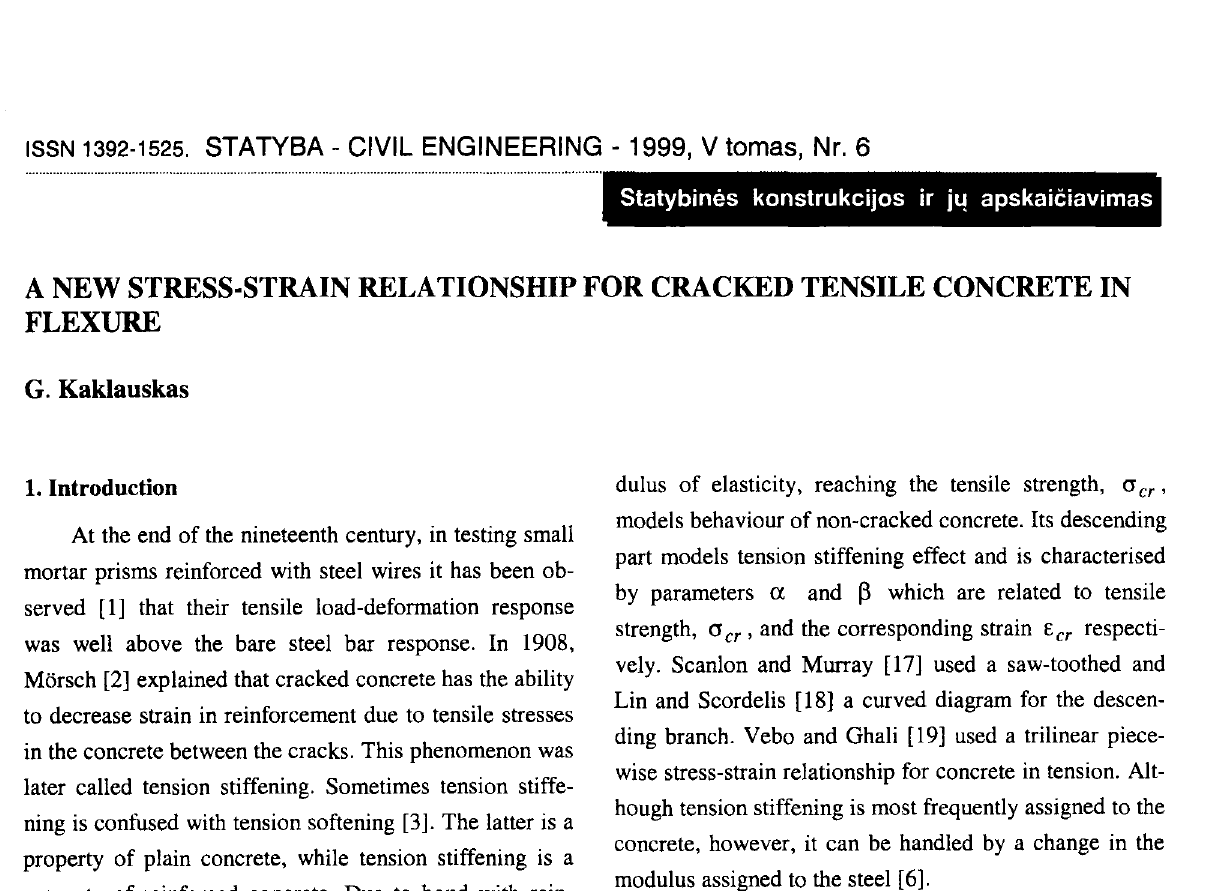
Fig 1. Average stress-strain relationship for concrete in tension Different fixed values of parameter ~ which